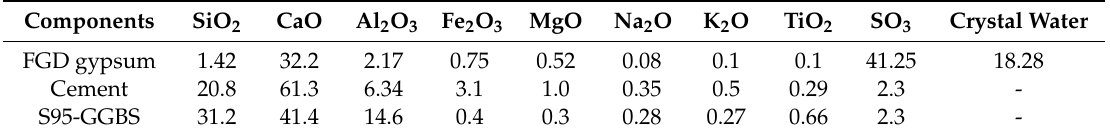
Table 1. Chemical compositions of raw materials (wt.%).